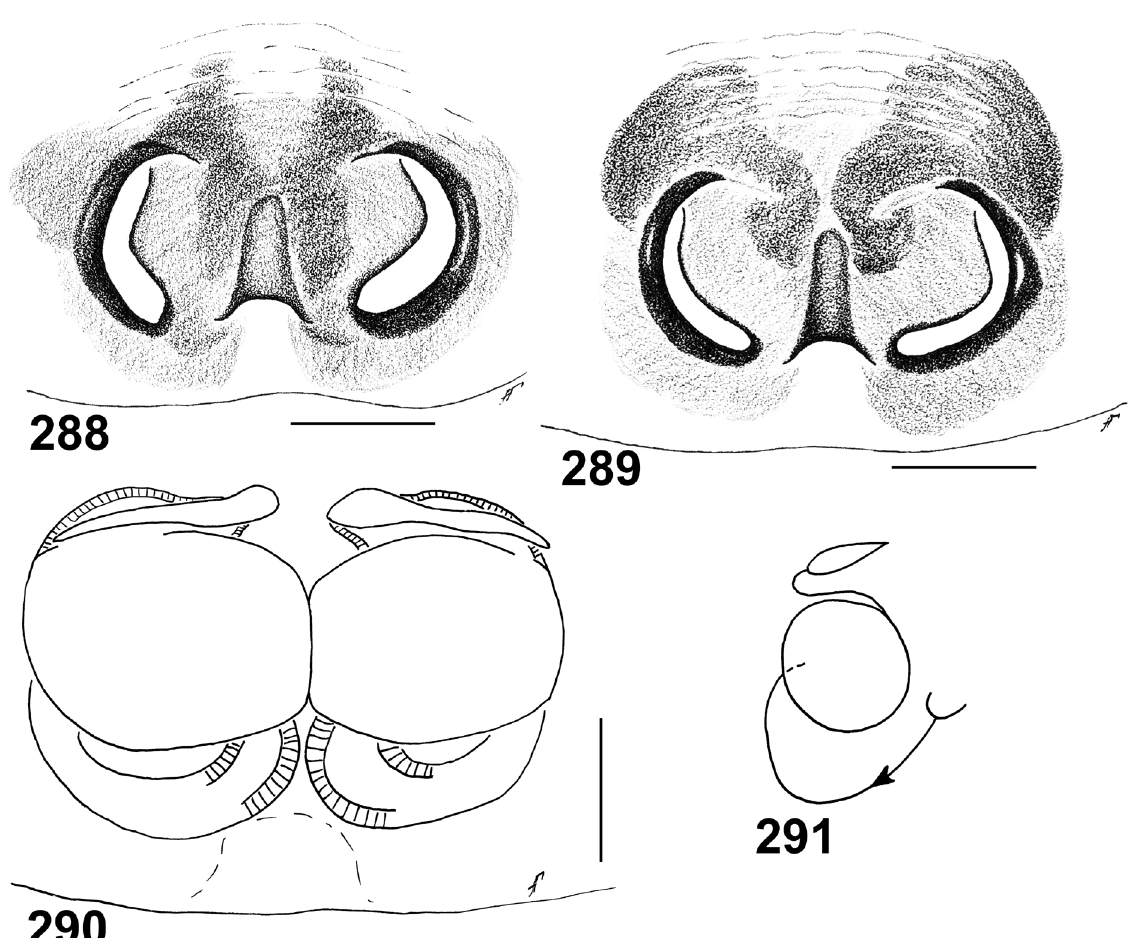
Figs 288–291. Stenaelurillus jocquei sp. nov., paratype ♀ from Cameroon (Faro GR; MRAC 221.132), light form. 288–289 . Epigyne, ventral view. 290 . Spermathecae, dorsal view. 291 . Diagrammatic course of the insemination ducts of the spermathecae. Scale bars: 0.1